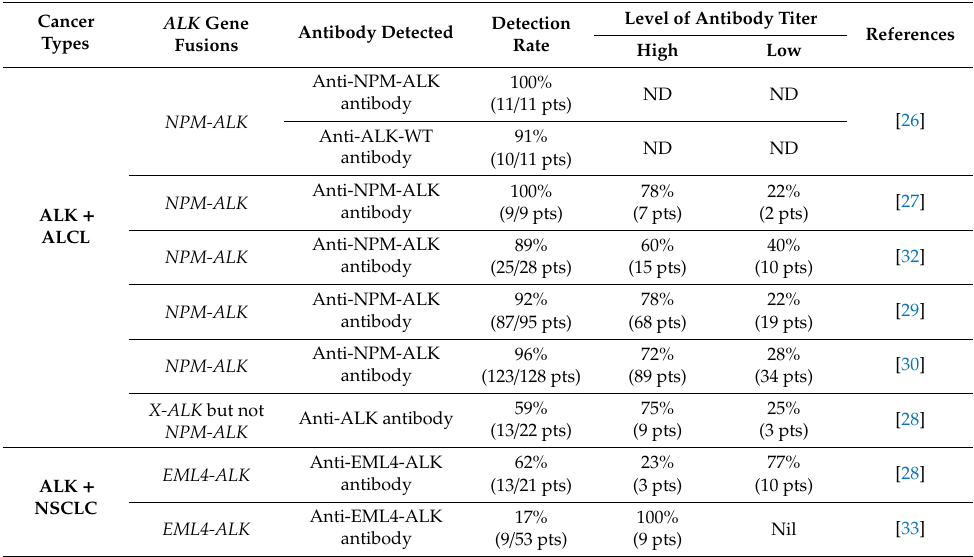
Table 2. Auto-antibody responses reported against ALK fusions in